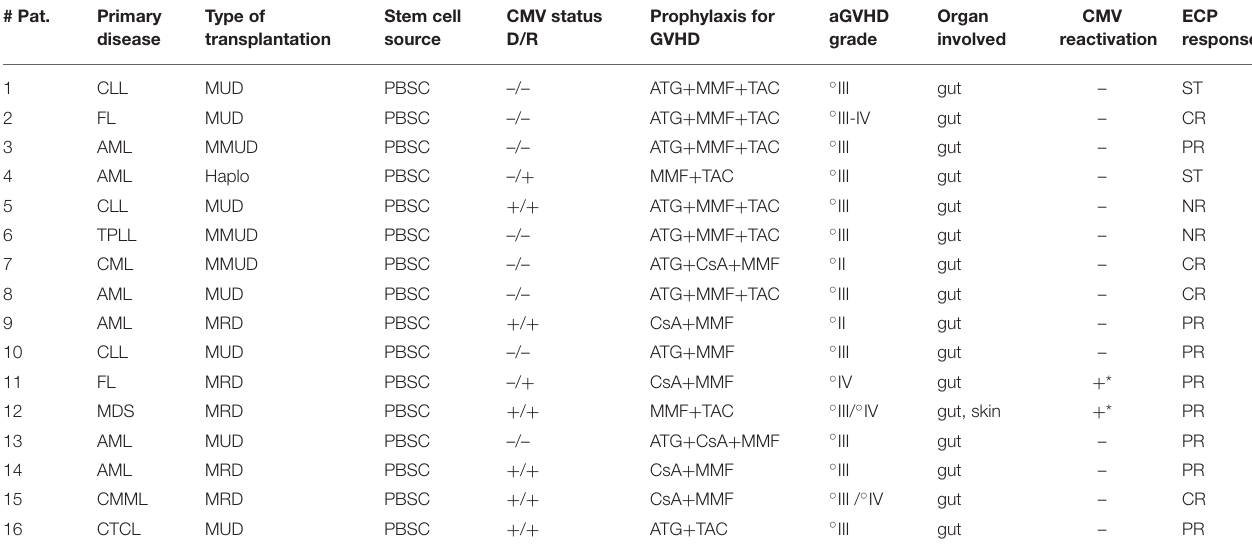
TABLE 1 | aGVHD patients’ characteristics and clinical response to ECP. # Pat.